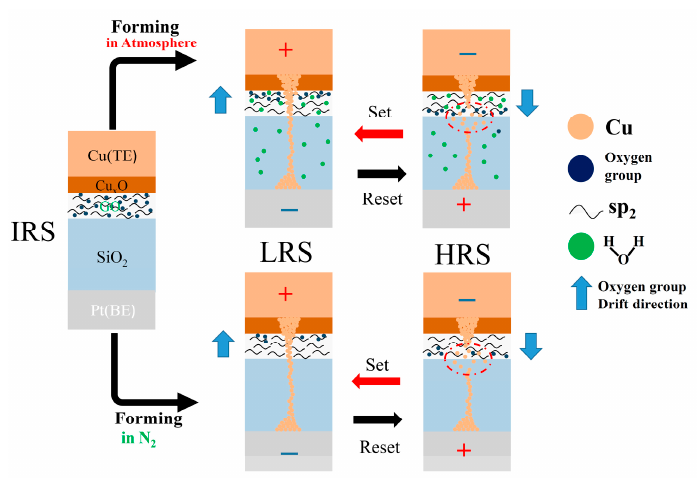
Figure 7. RS model of the GO sample in the atmosphere and the N 2 ambient.